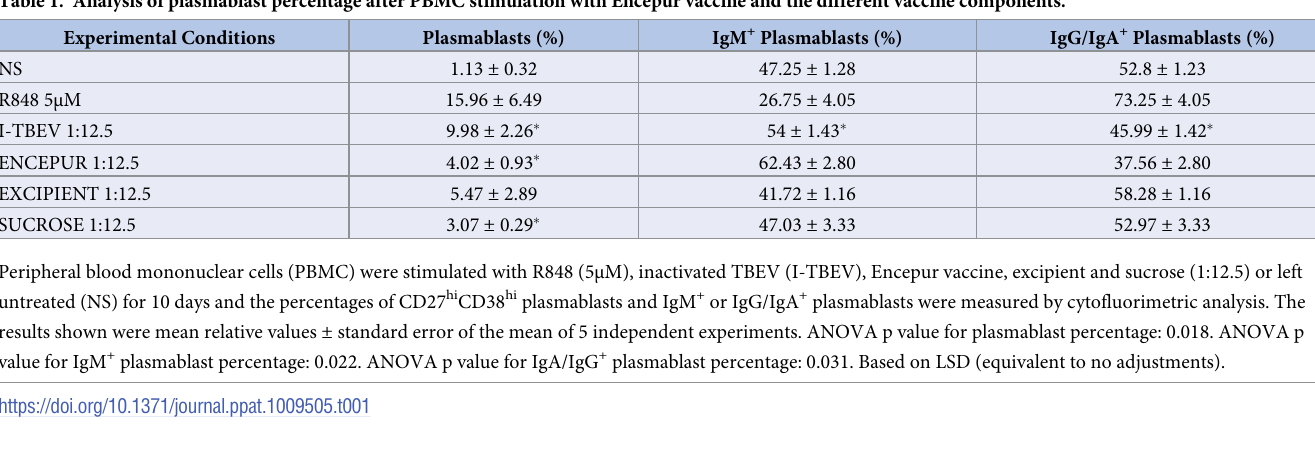
Table 1. Analysis of plasmablast percentage after PBMC stimulation with Encepur vaccine and the different vaccine components. Experimental Conditions